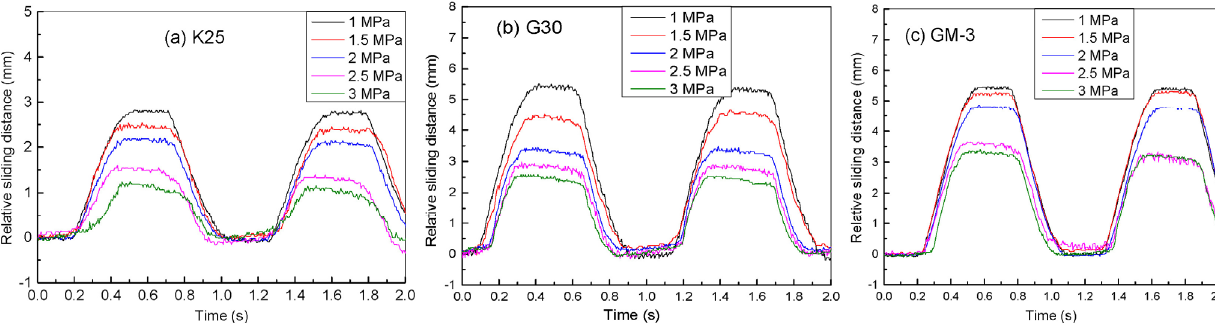
Fig. 8 Relative sliding distance of the friction lining in the sliding direction: (a) K25 lining, (b) G30 lining, and (c) GM-3